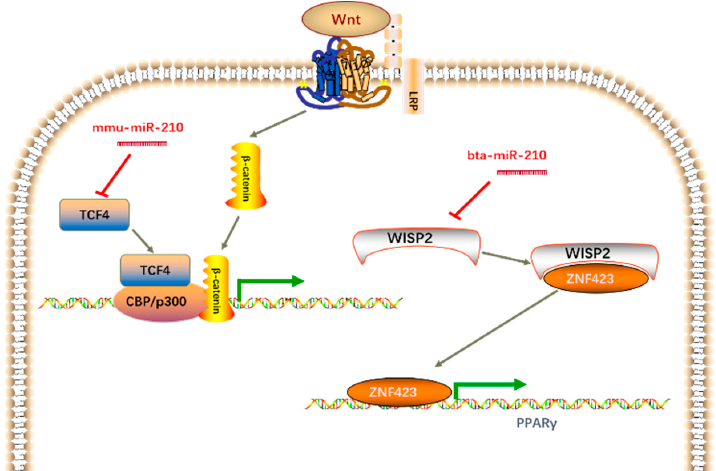
Figure 7. Distinct mechanism of miR-210 in the regulation of mouse and cattle adipogenesis. The canonical Wnt signaling pathway is presented in the figure. Arrows indicate positive regulation, and bars indicate negative regulation.